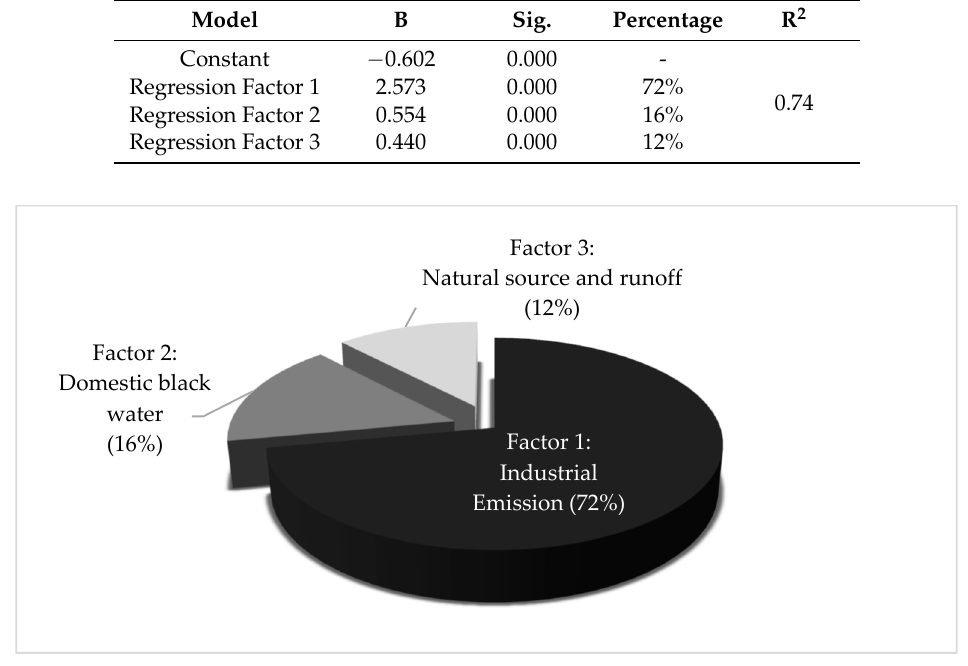
Figure 7. Source apportionment of water pollutant in the Erren River.